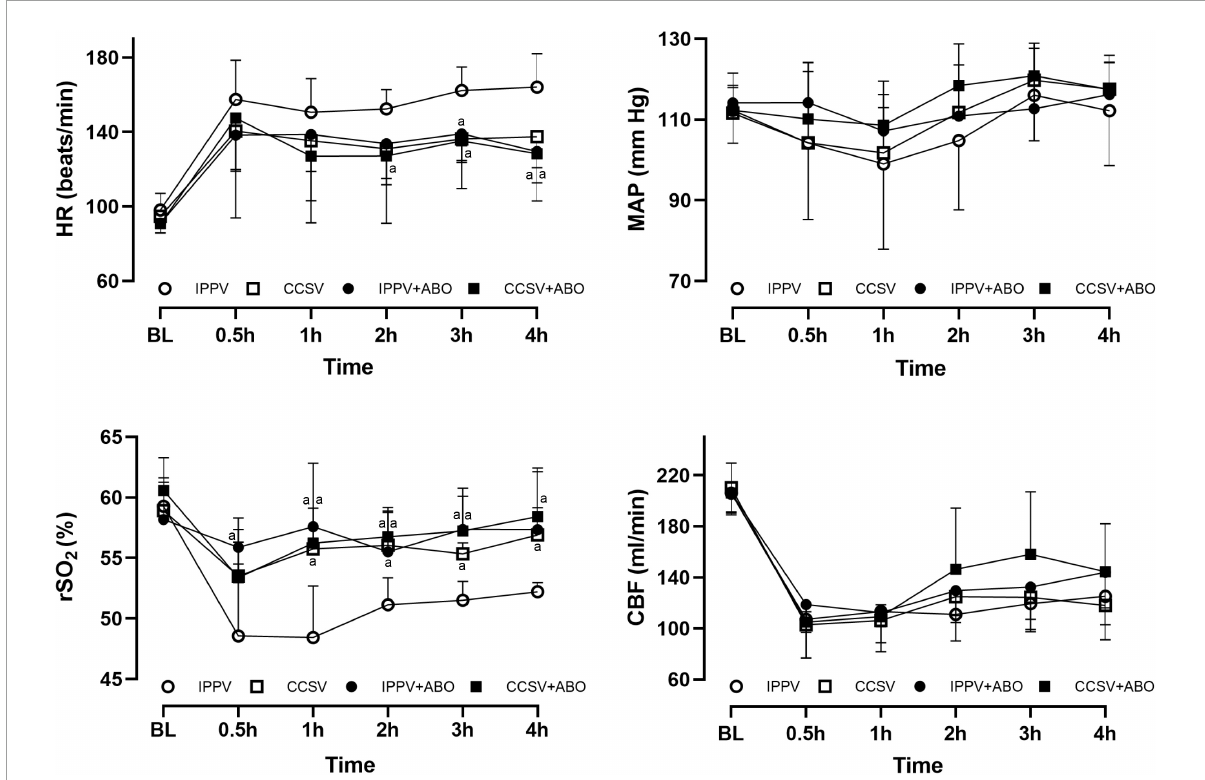
FIGURE3 The changes of heart rate (HR), mean arterial pressure (MAP), regional cerebral oxygen saturation (rSO 2 ), and carotid blood flow (CBF) at baseline (BL) and after resuscitation. IPPV, intermittent positive pressure ventilation; CCSV, chest compression synchronized ventilation; ABO, aortic balloon occlusion. Each group contained 7–10 swine at BL, and 4–7 swine after resuscitation, respectively. a P < 0.05 for CCSV + ABO group, IPPV + ABO group, CCSV group vs. IPPV